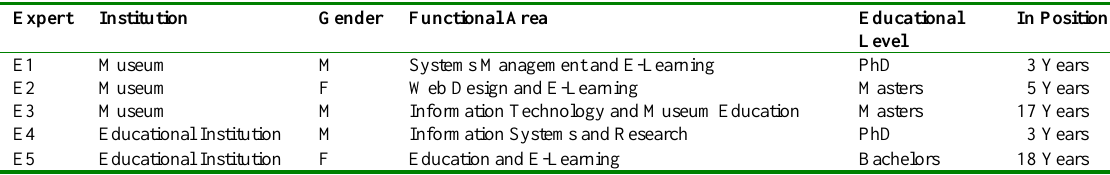
Table 1. Profiles of experts participating in the study